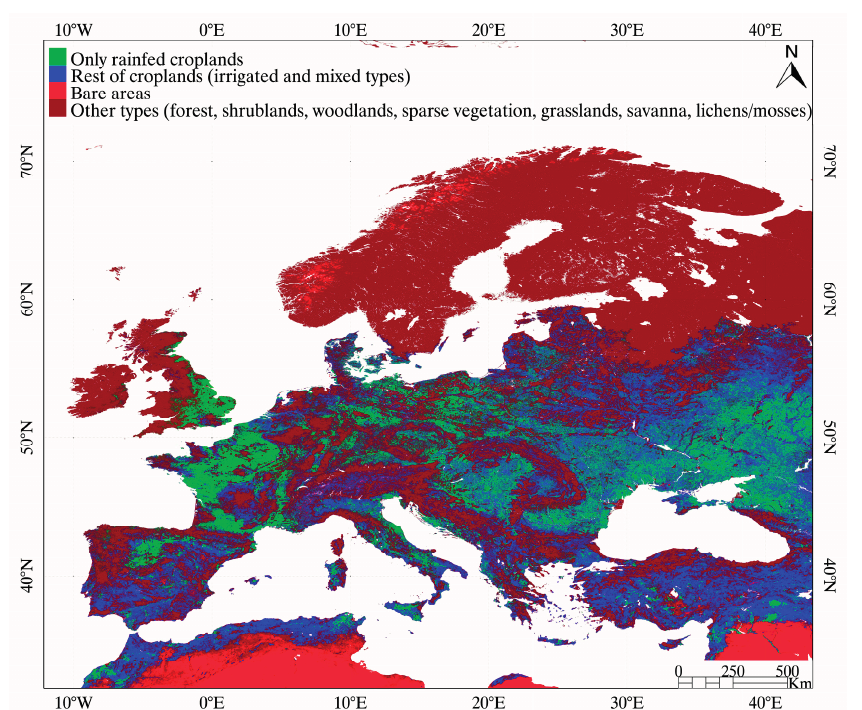
Figure 1. Pixel type (only rain–fed croplands, rest of croplands, bare areas, others) from the GlobCover classification